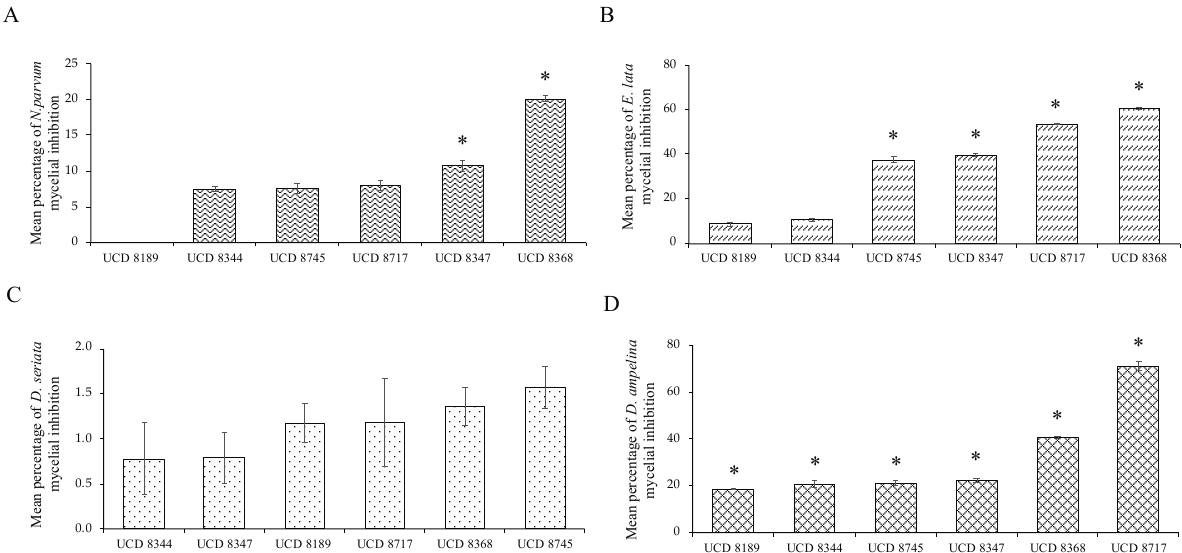
Figure 4. Mean proportions (%) of inhibition of radial mycelium growth of the grapevine trunk disease pathogens (A) Neofusicoccum parvum, (B) Eutypa lata , (C) Diplodia seriata and (D) Diaporthe ampelina in assays for volatile organic compound using the sealed-base- plates method with modifications. Values are means (± standard errors) of ten replicates. * indicates inhibition in comparison with controls (Dunnett’s test; P ≤